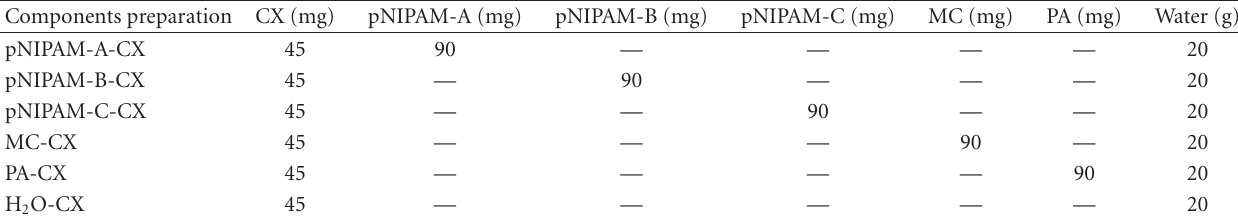
Table 1: Composition of investigated